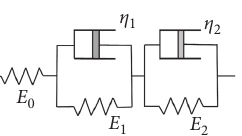
Figure 30: Modified second-order extensive Kelvin model